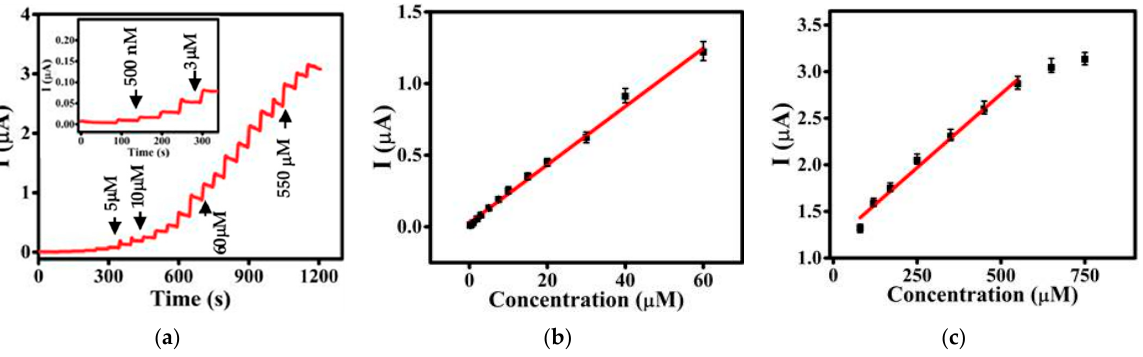
Figure 7. ( a ) Amperometric response of Sp ‐ At/MWCNTs/CPE with successive additions of different concentrations of GA from 250 nM to 550 μ M in 0.1 M phosphate buffer (pH 4) at 0.35 V. Inset: partial magnified view of the calibration curve for low concentrations of GA from 250 nM to 3 μ M. The current ‐ GA concentration calibration curve for ( b ) low and ( c ) high concentrations of GA.